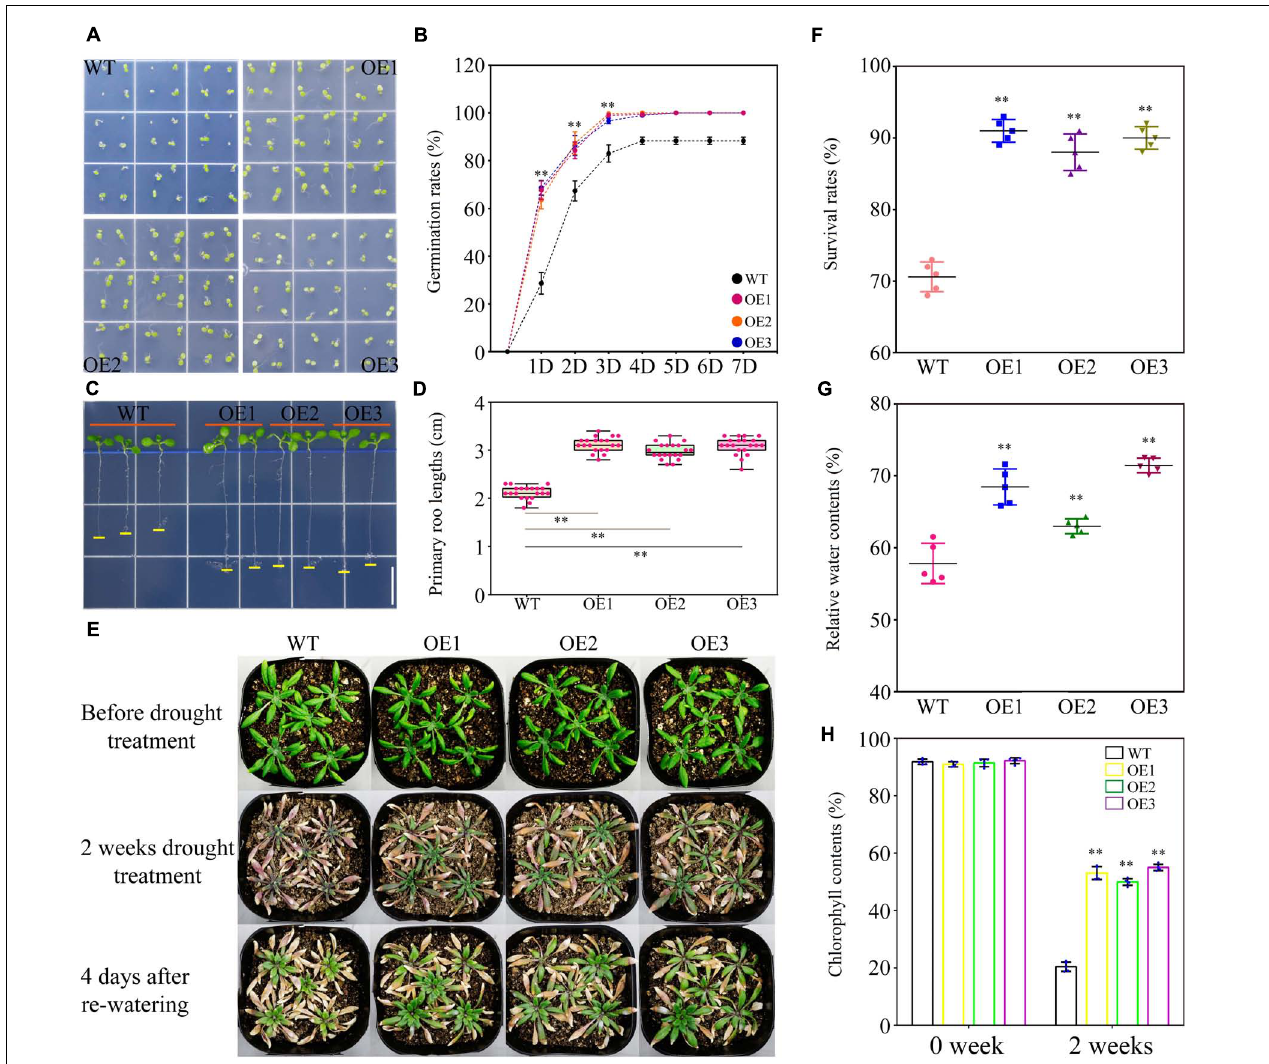
FIGURE 6 | Overexpression of TaWRKY75-A enhances drought tolerance in transgenic Arabidopsis . (A) Observation of seed germination in wild type (WT) and OE lines at 4 days after germination. (B) Seed germination rate of WT and OE lines within a week. One-way ANOVA followed by Tukey honest significant difference (HSD) test was performed. ∗∗ p < 0.01. Bars indicate means ± SD. This experiment was replicated five times. (C) Observation of the primary root elongation of WT and OE lines at 7 days after germination. Scale bar: 1 cm. (D) Statistics of lengths of the primary root of WT and OE lines at 7 days after germination. One-way ANOVA, followed by Tukey HSD test, was performed. ∗∗ p < 0.01, n = 20. Bars show the maximum and minimum values. (E) Observations of WT and OE seedlings during drought test. (F) Statistics of the survival rate of WT and OE lines at 4 days after re-watering. One-way ANOVA, followed by Tukey HSD test, was performed. ∗∗ p < 0.01. Bars indicate means ± SD. This experiment was performed five times. (G) Quantification of the relative water content of the leaves of WT and OE lines after 2 weeks of drought treatment. One-way ANOVA, followed by Tukey HSD test, was performed. ∗∗ p < 0.01. Bars indicate means ± SD. This experiment was performed five times. (H) Statistics of the chlorophyll content of the leaves of WT and OE lines after 2 weeks of drought treatment. One-way ANOVA, followed by Tukey HSD test, was performed. ∗∗ p < 0.01. Bars indicate means ± SD. This experiment was performed five